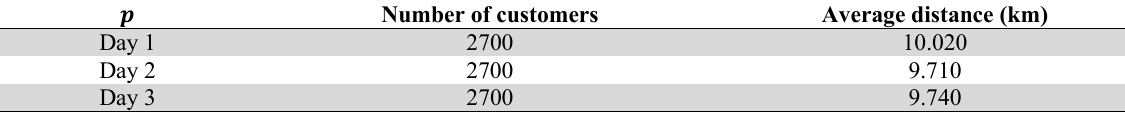
Fig. 5. Geographical distribution of customers allocated in scheduling phase Results of scheduling phase for three days in the case study